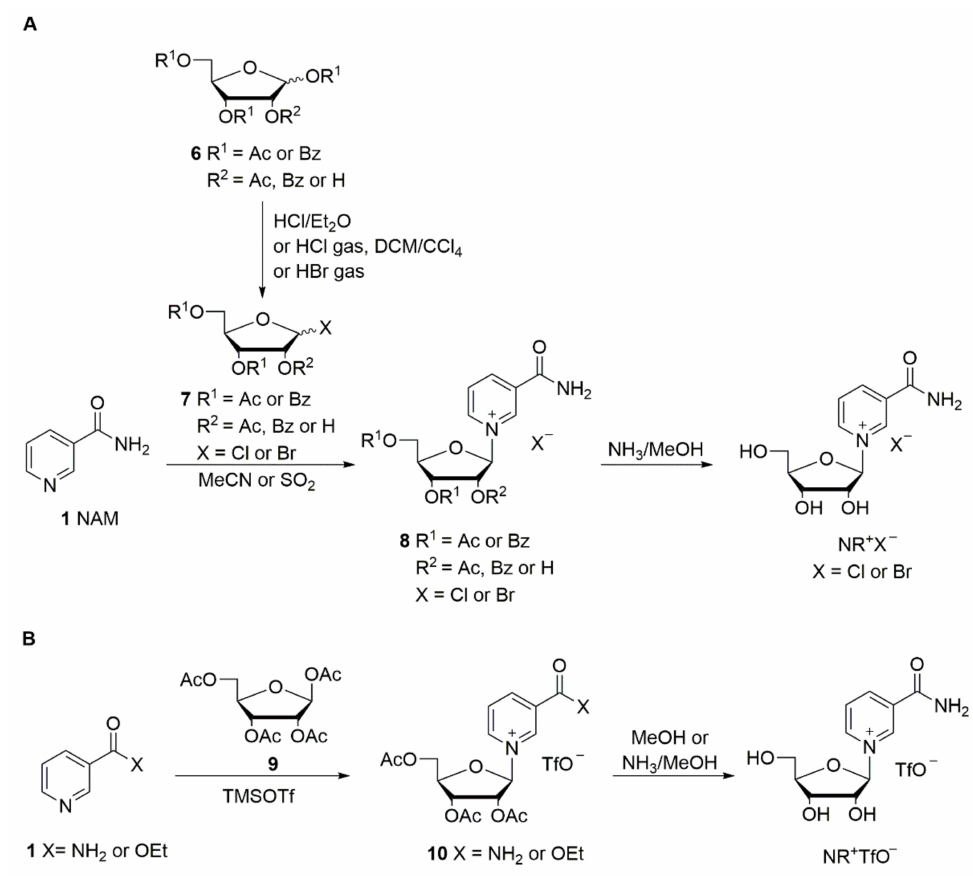
Scheme 2. Adapted from Makarov and Migaud